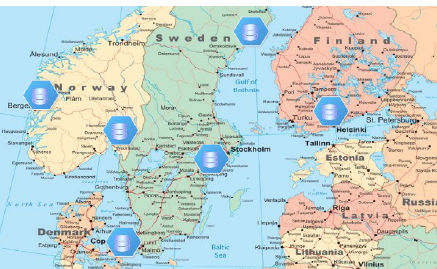
Figure 1: NDGF Tier-1 - Five countries (Slovenia is not shown), one dCache. The AGLT2 is a WLCG distributed Tier-2 site, formed from a collaboration between the University of Michigan and Michigan State University. They provide an excellent example of dCache’s federation ability. Data ingested at any campus is written locally, using storage nodes located on site. However, as this is a single dCache instance, the files are represented in a single namespace and may be accessed from any